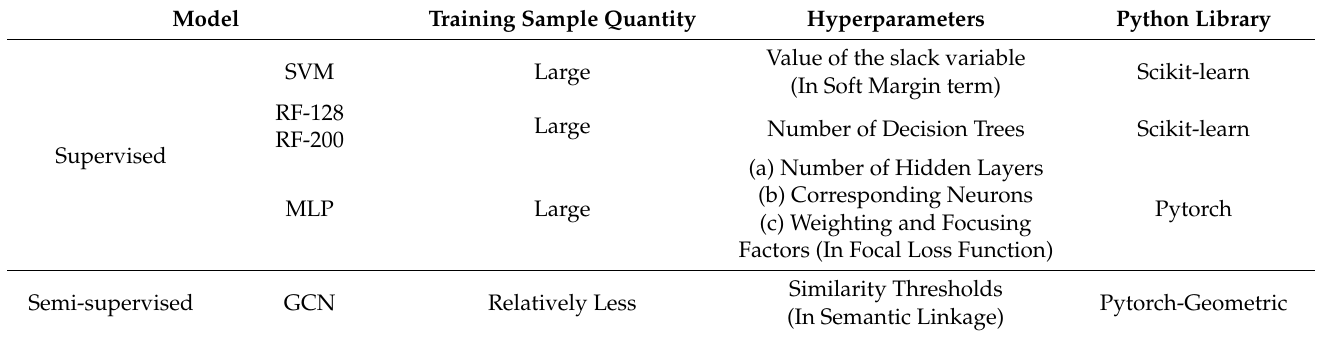
Table 2. Characteristics and implementation details of 5 models compared in this